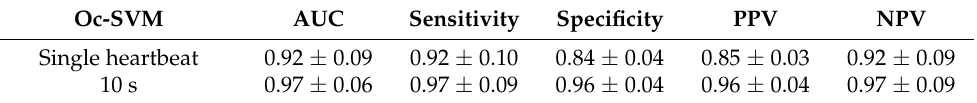
Table 4. Feature importance of Oc-SVM model in predicting